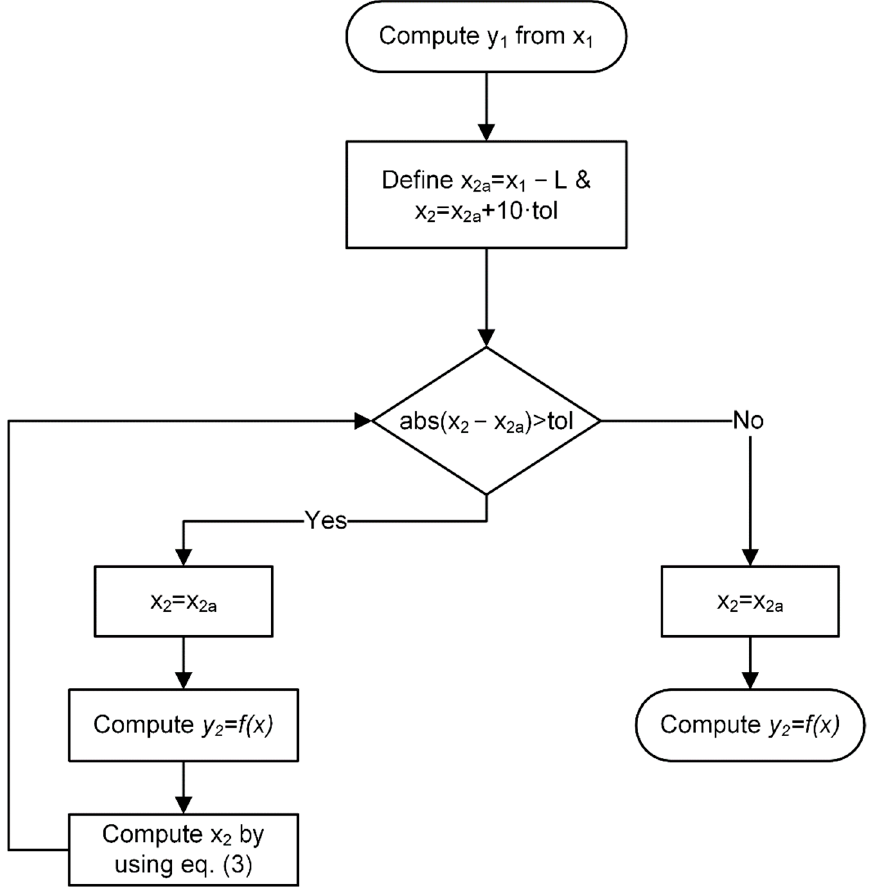
Figure 1. Flowchart for computing the position of the rear wheel.